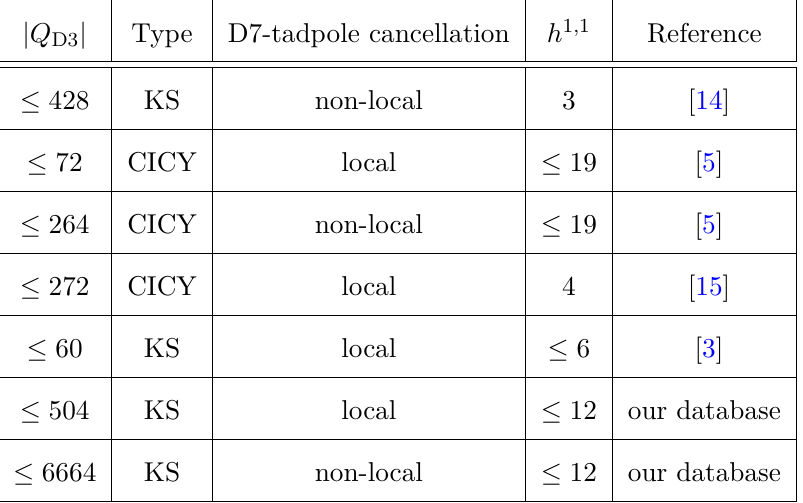
Table 1 . List of values for the total D3-charge contribution to the D3-tadpole. contribute differently to the D3